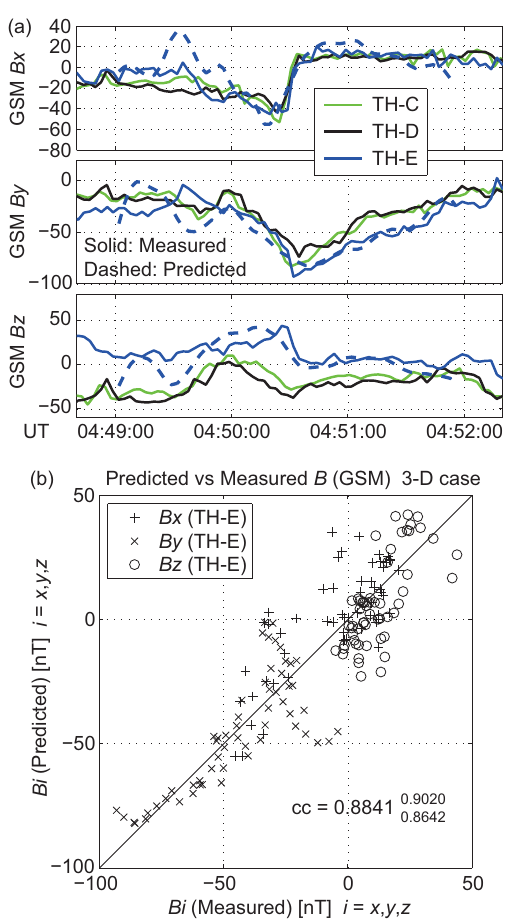
Figure 3. (a) Time series of three GSM components of the magnetic field actually measured (solid) and predicted (dashed) along the THE path (blue), along with the THC (green) and THD (black) data used for the 3-D reconstruction. (b) Correlation between the three GSM components of the predicted and measured fields at THE, but excluding the data points closest to the X boundaries of the recon- struction domain. The subscript and superscript of the correlation coefficient represent the upper and lower values of the confidence interval corresponding to ± 1